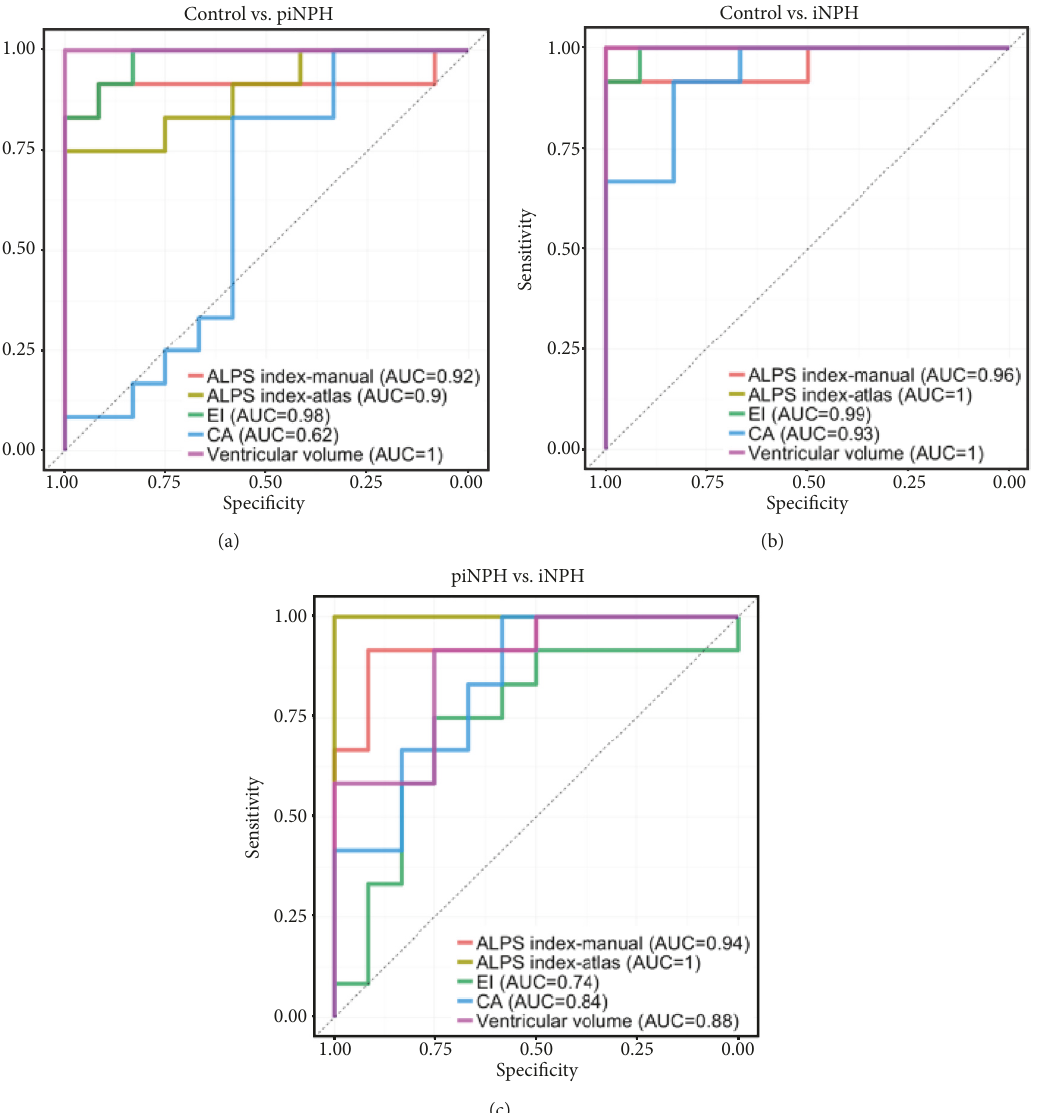
Figure 5: ROC curve analysis between the control vs. piNPH (a), the control vs. iNPH (b), and the piNPH vs. iNPH (c). ALPS index with the manual and the atlas-based methods, EI, CA and supratentorial ventricular volume were assessed.